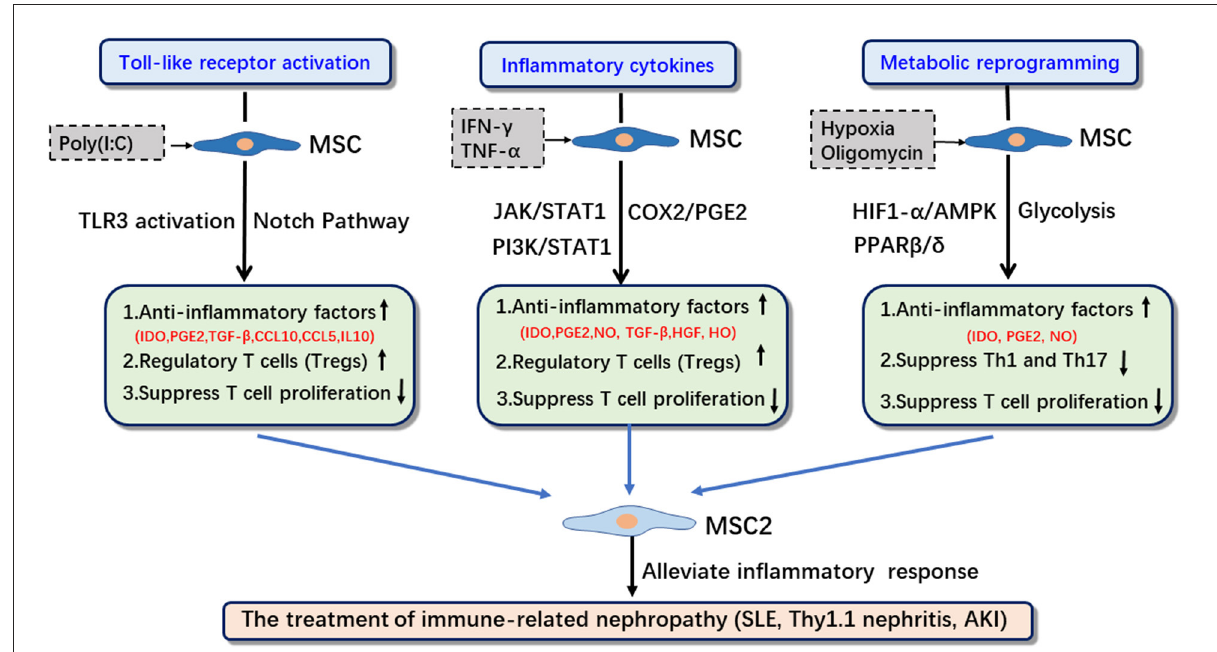
FIGURE1 The induction strategies, related signaling pathways and applications of MSC2. IDO, indoleamine 2,3-dioxygenase; PGE2, prostaglandin E2; HO, heme oxygenase-1; SLE, systemic lupus erythematosus; IRI, ischemia reperfusion injury; Thy1.1, Thy-1.1 nephritis.